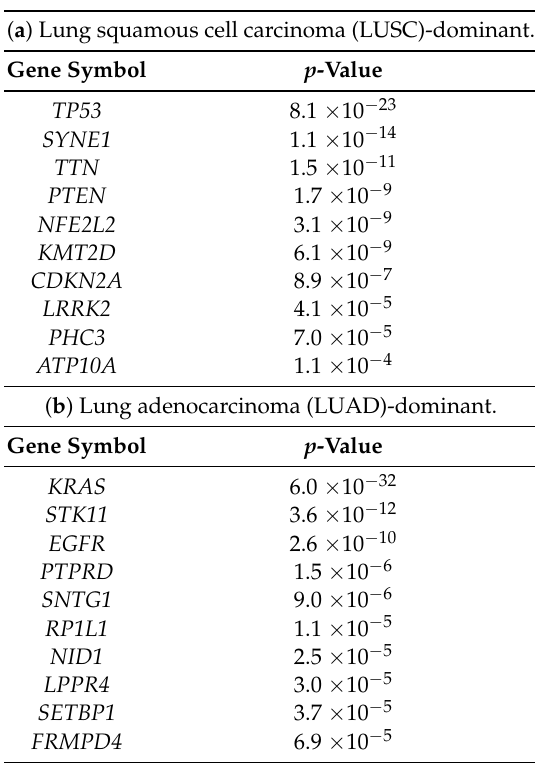
Table 3. Ten most frequent dominant somatic mutations for each histology.